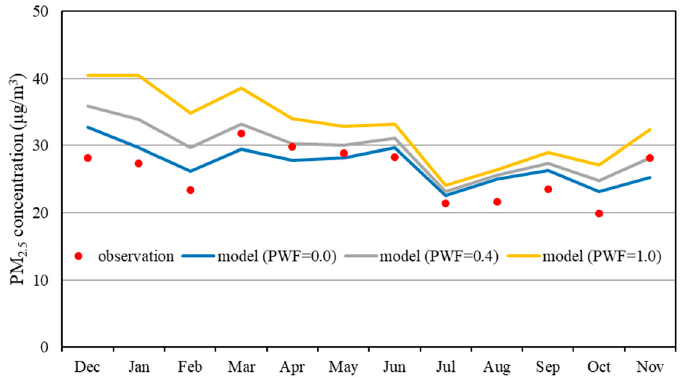
Figure 8. Observed and forecasted monthly mean PM 2.5 concentrations at Seoul with the pcSOA weighting factors (PWF) of 0, 0.4 and 1.0.